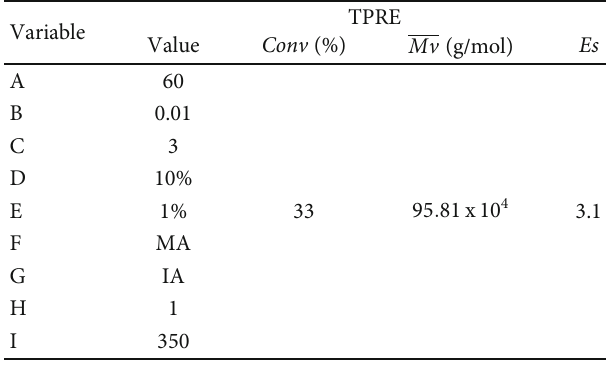
Table 8: Terpolymerization conditions and characterization of TPRE.